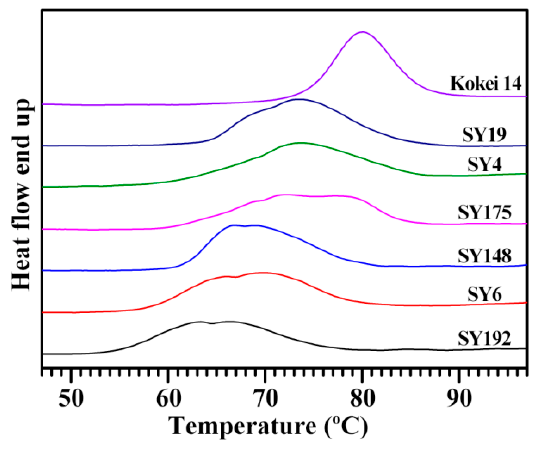
Figure 3. DSC thermograms of C-type starches from different sweet potato varieties. Table 5. Thermal property parameters, swelling powers and water solubilities of C-type starches from different sweet potato varieties.